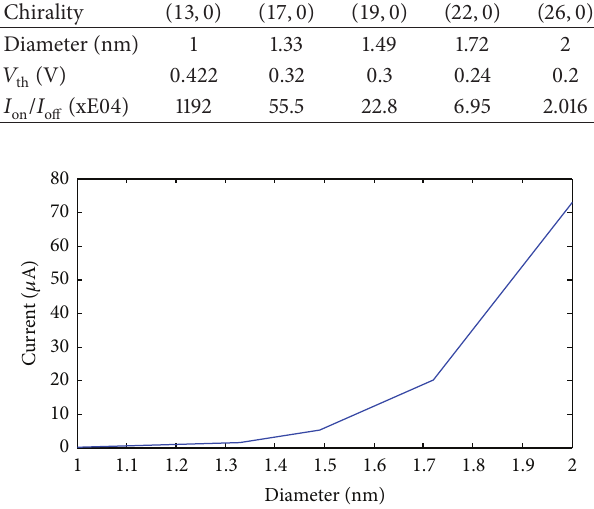
Figure 4: The current with variations of diameter of CNT for pure- CNFET.